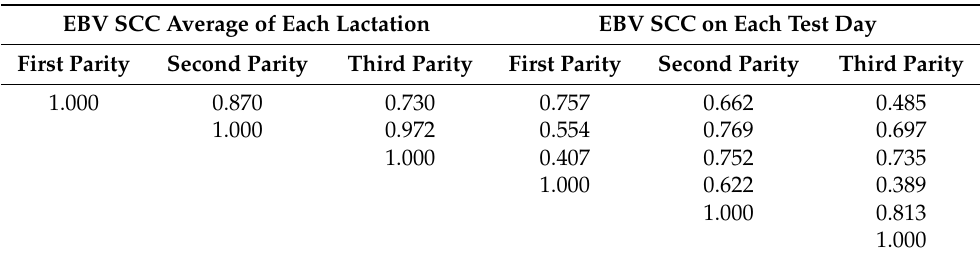
Table 4. Estimates of the correlations between the breeding values of the goats (EBV) for somatic cell counts in different parities (expressed as the average of lactation or each test day). EBV SCC Average of Each Lactation EBV SCC on Each Test Day